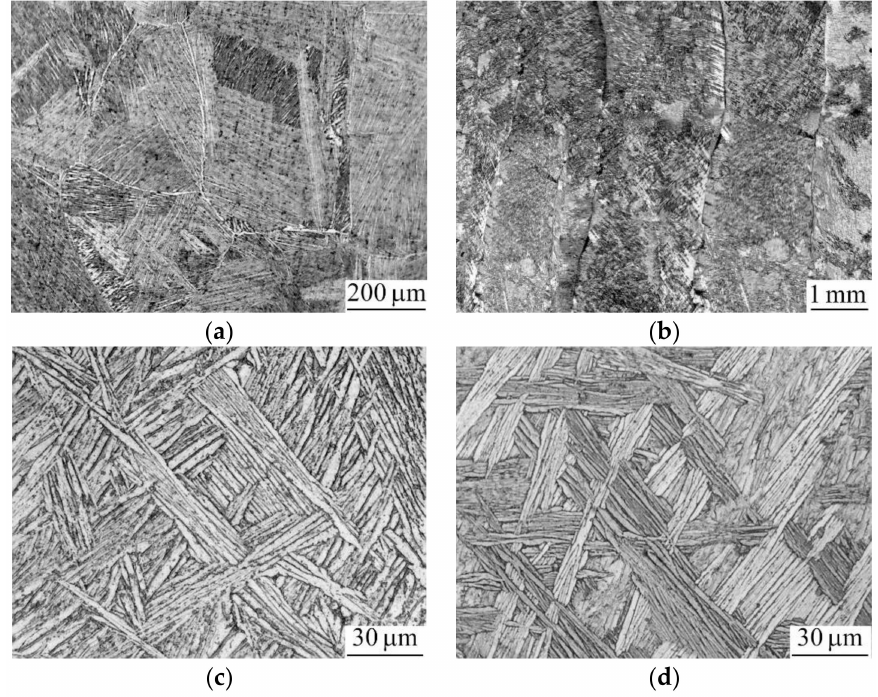
Figure 2. Typical microstructures of the wrought ( a , c ) and EBAM Ti-6Al-4V samples ( b , d